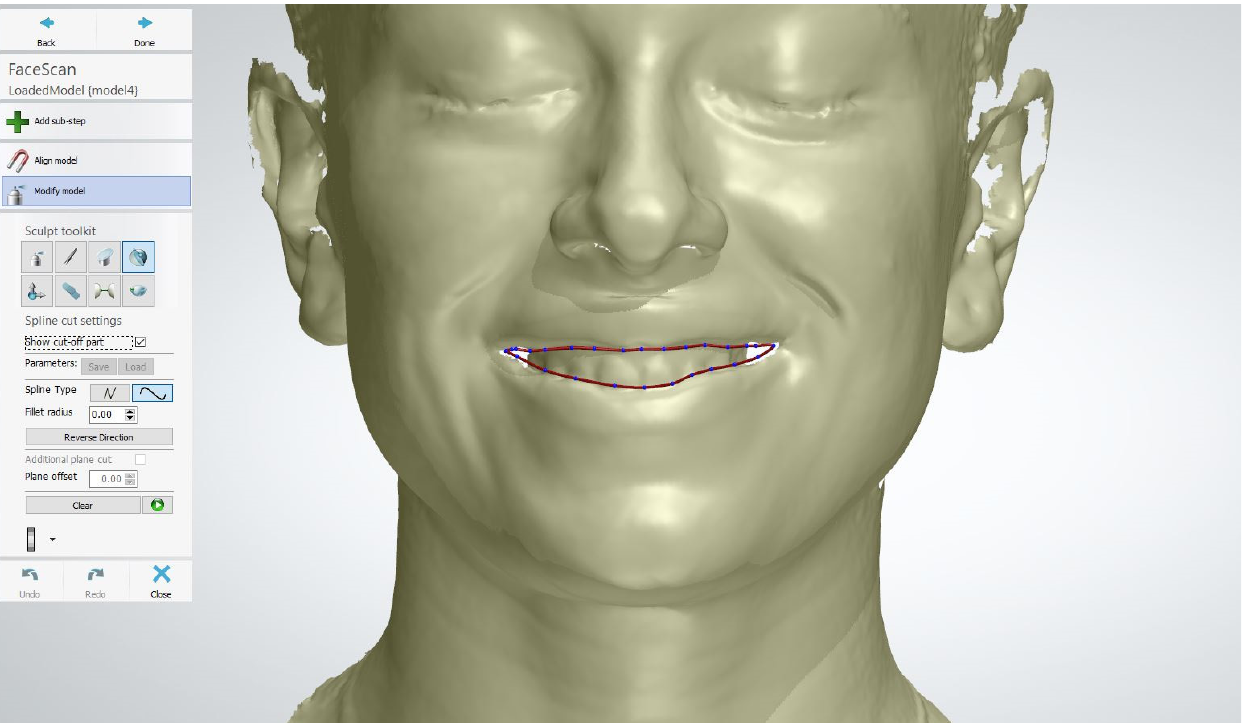
Figure 7. Matching the face scan with retractor with the face scan with smile.